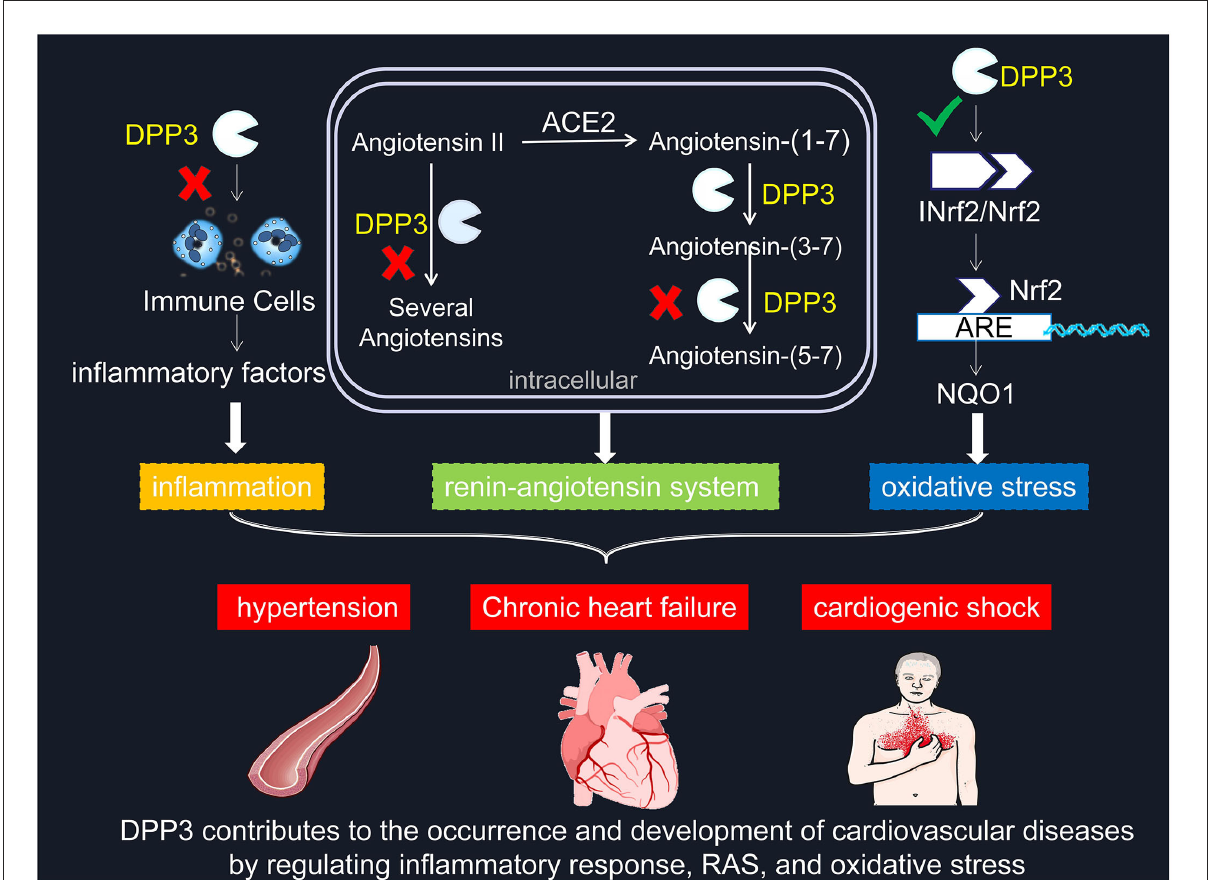
FIGURE1 DPP3 contributes to the occurrence and development of cardiovascular diseases by regulating inflammatory response, RAS, and oxidative stress. represents blocking this pathway. √ means promoting this mechanism. DPP3, Dipeptidyl peptidases 3; RAS, renin-angiotensin system; × Nrf2, Nuclear factor-erythroid-2-related factor 2; INrf2, inhibitor of Nrf2; NQO1, quinone oxidoreductase